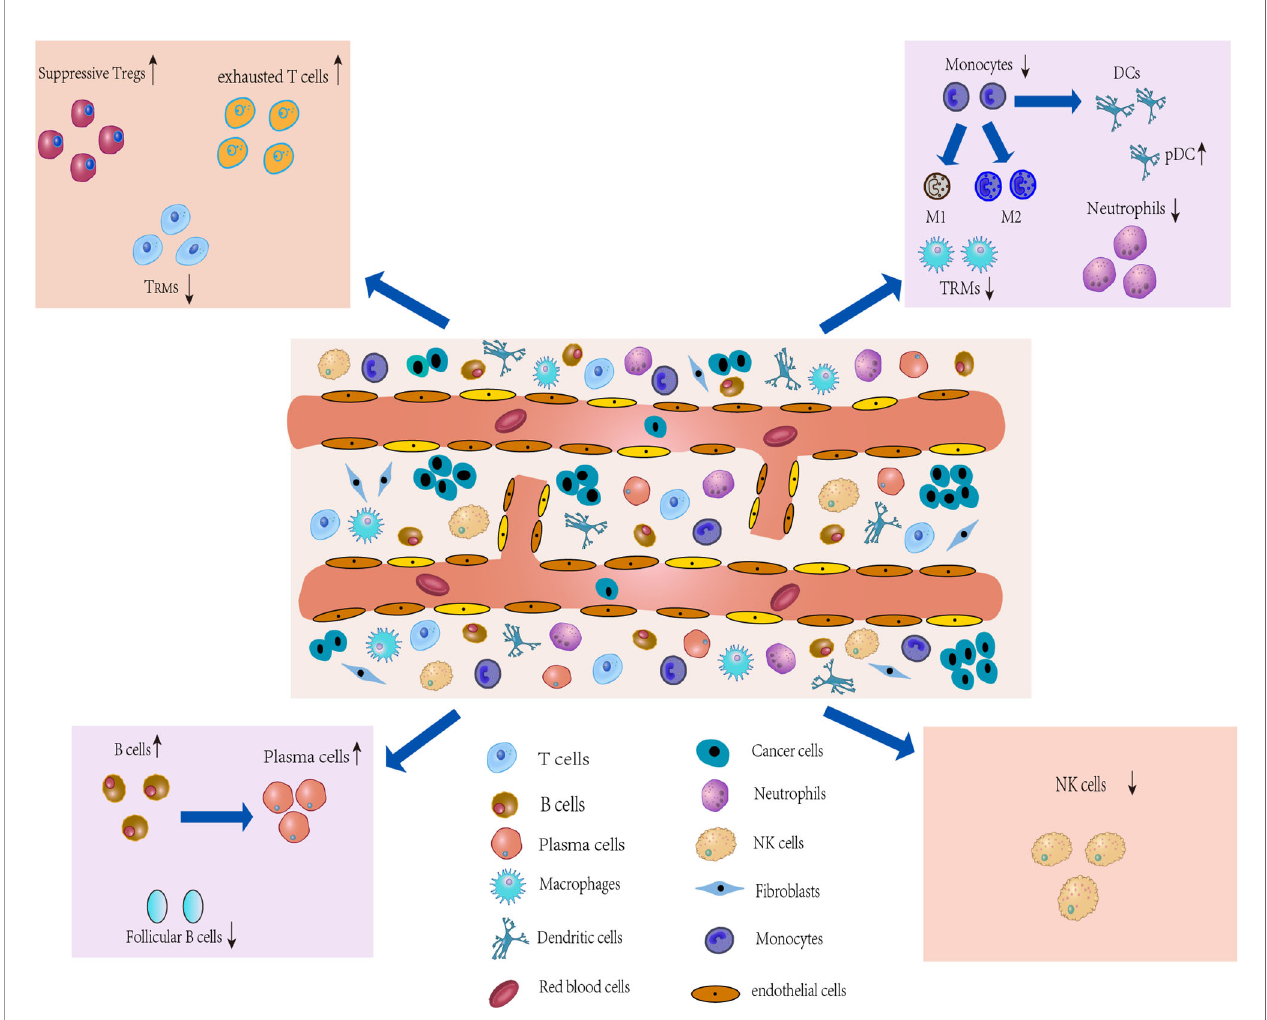
FIGURE 2 | Characterization of the TME and development of IICs. The TME of lung cancer consists of multiple heterogeneous cell types, such as T cells, tumorassociatedmacrophages (TAMs), an CAFs. The number and phenotype of IICs change in the TME, and differential expression occurs. These different types of cells in the TME, along with lung cancer cells, drive the microenvironment toward